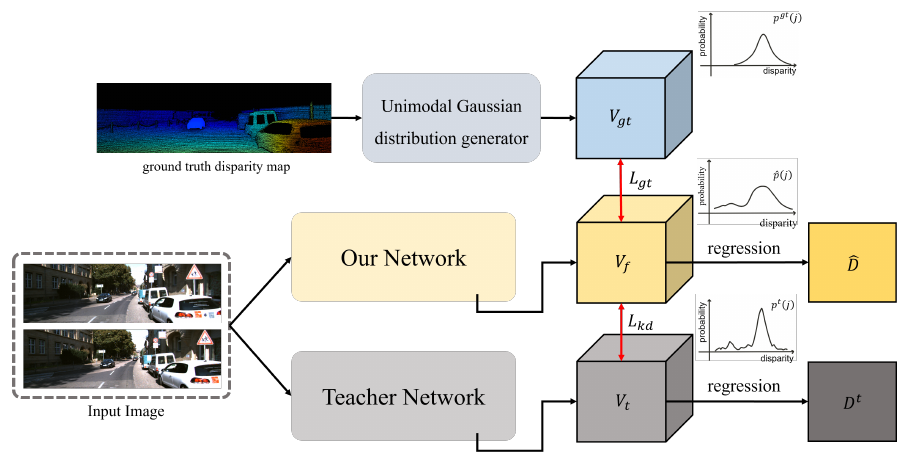
Figure 8. Process of adaptive cost volume